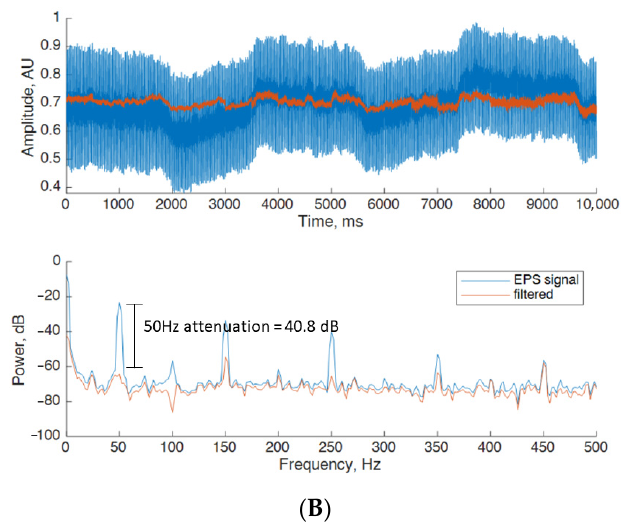
Figure 5. ( A ) Unconventional electric field sensors placed on the human forehead for EOG bio-signal collection. ( B ) Experimental results when applying the proposed denoising method on EOG bio- signals. Figure 4B: ( top ) Human EOG signal collected using the EPS sensors before (labelled EPS signal) and after (labelled filtered) the denoising method is applied; ( bottom ) PSD measured before and after the denoising method is applied.